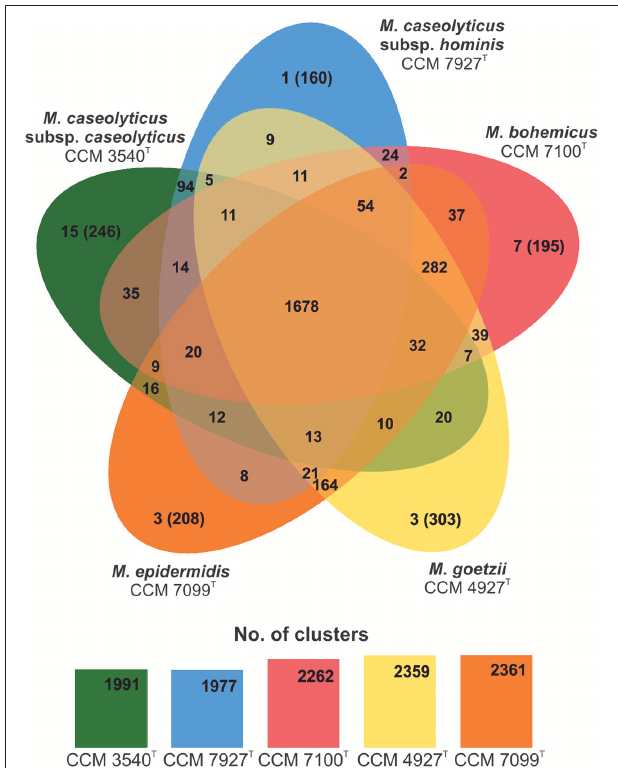
FIGURE 2 | Venn diagram showing shared orthologous protein clusters among genomes of human macrococcal isolates and Macrococcus caseolyticus subsp. caseolyticus subsp. nov. CCM 3540 T . The number of protein clusters predicted by RAST comprised of multiple protein families is indicated for each genome. The orthologous clusters were identified with the default parameters, 1e − 5 e-value cutoff for all protein similarity comparisons and 1.5 inflation value for the generation of orthologous clusters. The number of singletons specific for each genome is shown in